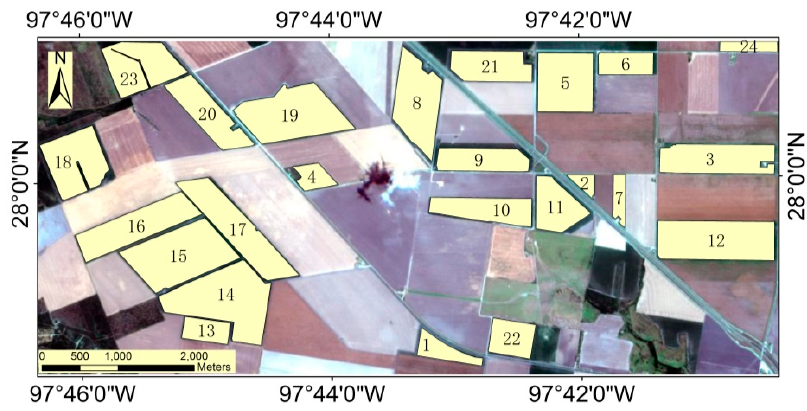
Figure 4. Twenty-four cotton fields in the study area.